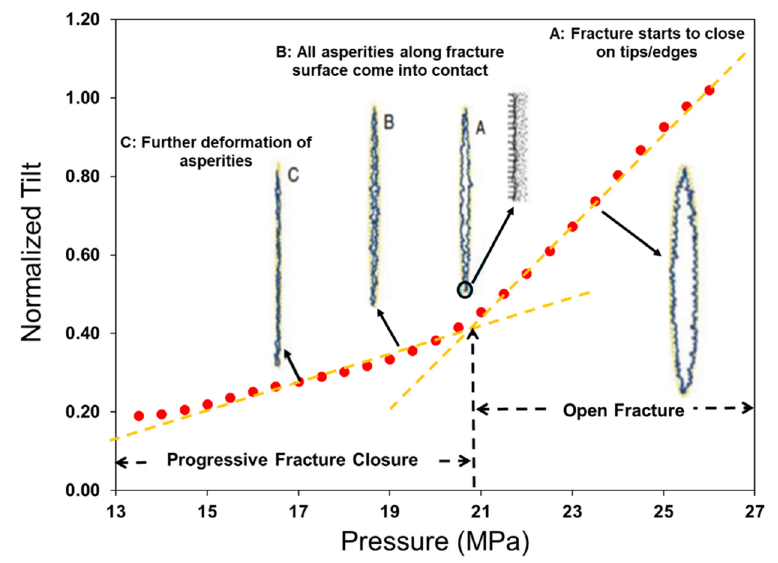
Figure 4. Observation of fracture closure behavior. Wang and Sharma [20] used recorded data to explain the relationship between nor- malized tilt and formation pressure (Figure 4). The data for this downhole field measure- ment were recorded and gathered immediately after the end of the several week-long test. The Y -axis presents the normalized tilt calculated by dividing each tiltmeter measurement by the maximum fracture displacement. The data were plotted vs. the wellbore pressure to generate the diagnostic plot (Figure 4), demonstrating a direct measurement of the rock deformation during the fracture closure behavior. The results indicate that the pressure falloff data response on a normalized tilt vs. formation pressure plot (Figure 4) is propor- tional to the fracture compliance (Equation (1), or inversely proportional to fracture stiff- ness, and the fracture closure behavior is a function of average displacement and fracture volume. The fracture volume is proportional to the average fracture width as the pressure continues to decrease, and two distinct periods are indicated on the diagnostic plot: (1) The trend of the pressure falloff data is a linear decline until the point of measured pres- sure inside the fracture, or closure pressure, is greater than 21 MPa (3046 psi). At this point, the fractures are still open, the stiffness factor is constant, and the surface area re- mains constant until the fracture wall comes into contact, or closure. The fracture geome- try can then be estimated directly using Table 2. (2) The pressure falloff data begin to de- viate from a straight line at the inflection point on the plot, where the closure pressure is marked with a dashed green line; therefore, the fracture stiffness increases gradually, as a result of the fracture closure on the asperities of the fracture edges or tips.